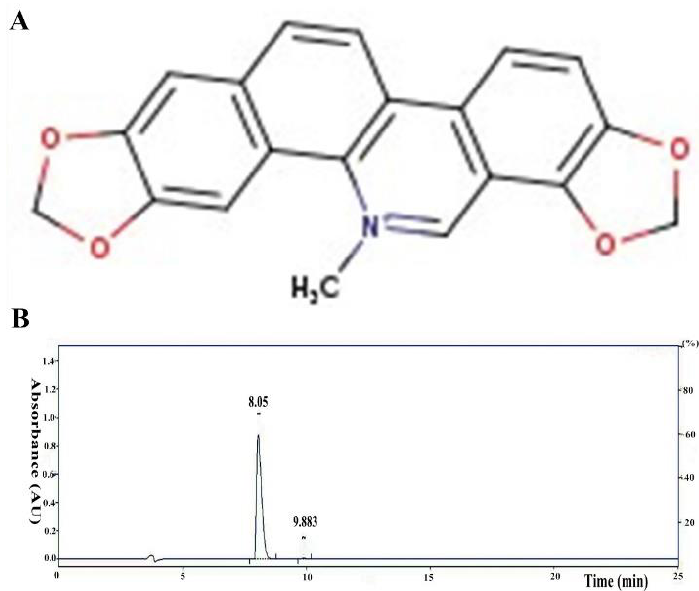
Figure 1. ( A ) The chemical structure of SG. ( B ) HPLC chromatogram of SG.